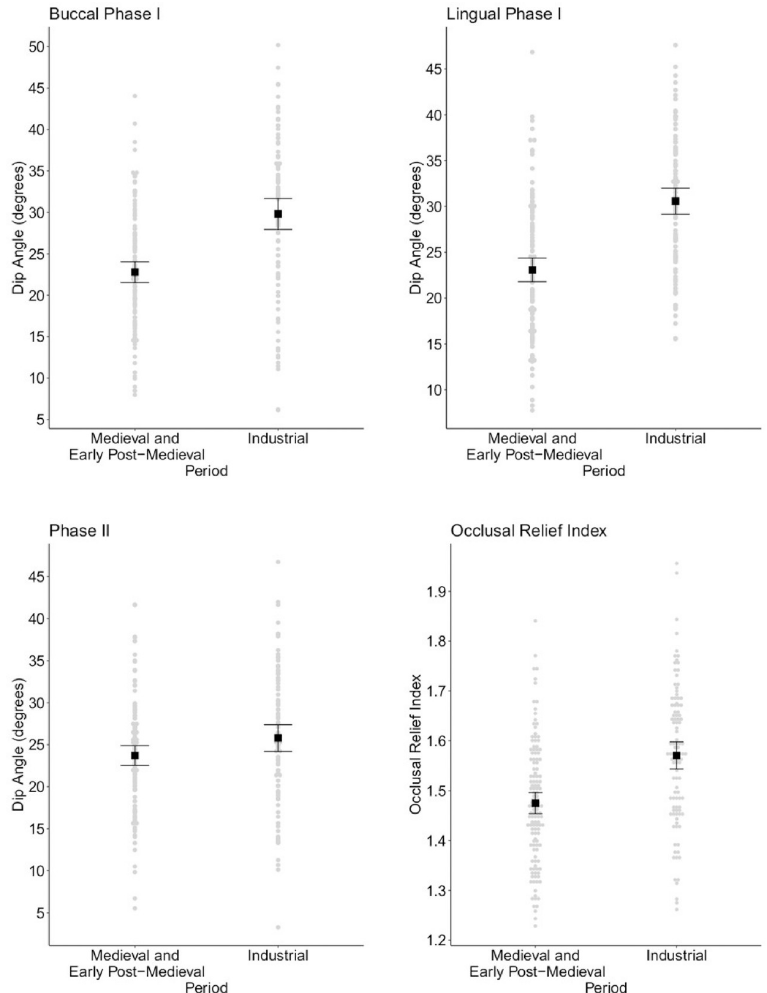
Fig 5. Comparison of dip angle and ORI between the pre-industrial and industrial group. Upper row and lower left: Plots comparing mean dip angle value for the lower second molars for buccal phase I, lingual phase I and phase II facets between the medieval and early post-medieval periods and the industrial period. The means are represented by black squares alongside error bars giving 95% confidence intervals. Grey dots visualise the dip angle value for each of the lower second molars assessed using OFA. Lower right: Plot comparing mean Occlusal Relief Index values for the lower second molars between the two periods (black squares with 95% confidence intervals). Grey dots visualise each individual ORI value for the lower second molar targeted by